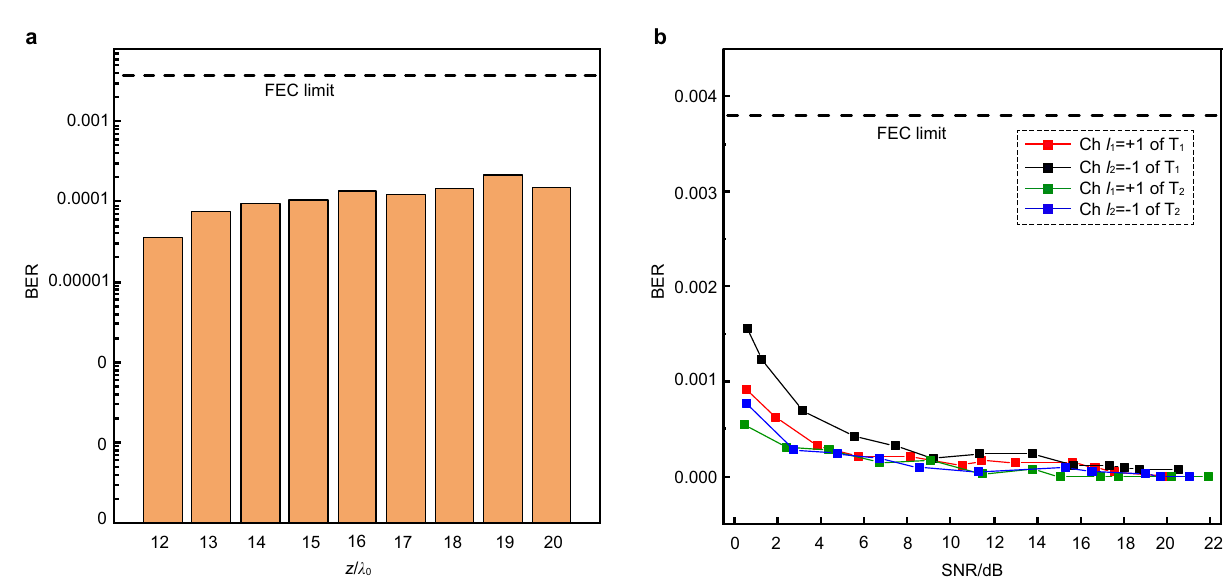
Fig. 5 | The measured BERs for the transmission of the binary image as a functionofthetransmissiondistanceandSNRrespectively.a MeasuredBERsof